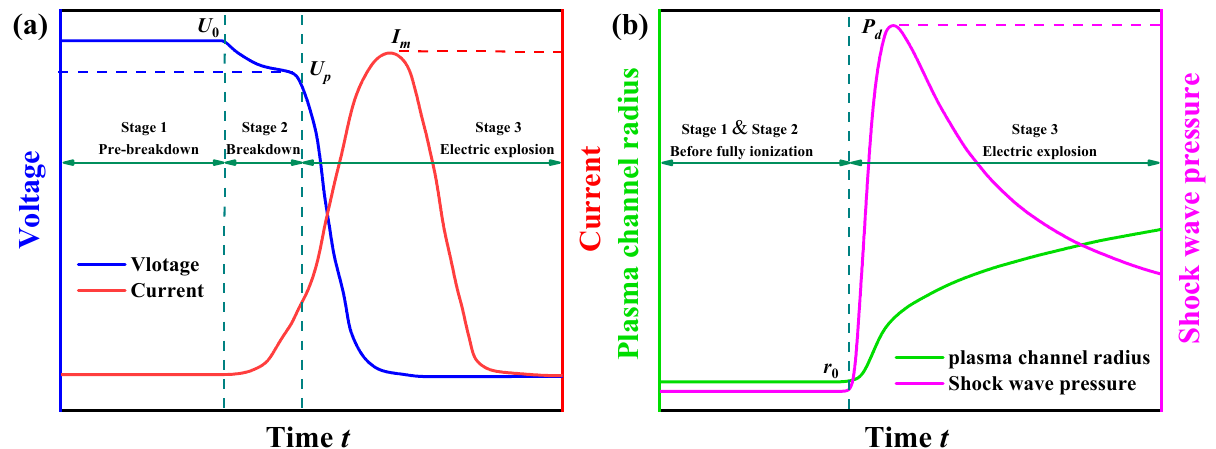
Figure 1. Three stages of the electrical pulse process about ( a ) the voltage and current of plasma channel, and ( b ) shock wave pressure and radius of plasma channel. U 0 is the peak voltage; U p is the initial voltage of the channel; I m is the peak current; r 0 is the initial radius of the plasma channel; P d is the peak shock wave pressure.